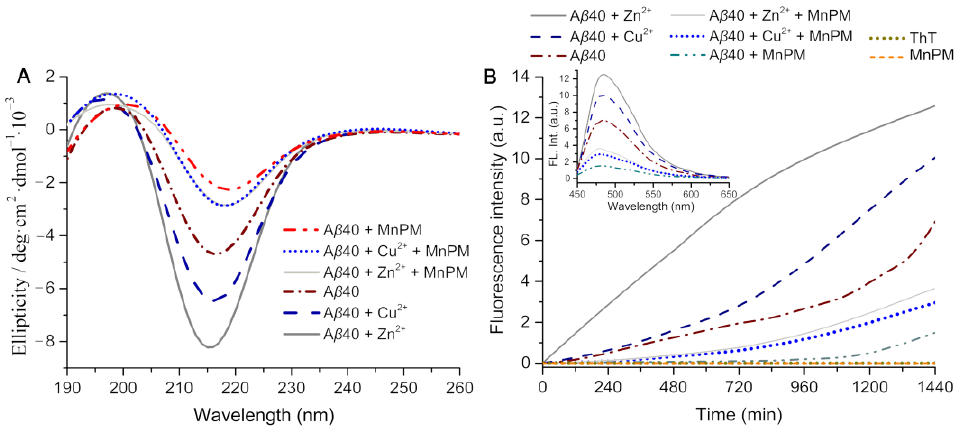
Figure 6. ( A ) CD spectra of A β 40 (20 µ M) and A β 40 in the presence of Cu 2+ or Zn 2+ (40 µ M) with or without MnPM (20 µ M) after incubation at 37 ◦ C for 24 h (All the samples with final DMSO content: volume ratio 0.5%); ( B ) ThT fluorescence intensity ( λ ex = 415 nm) of A β 40 (20 µ M) solutions in the absence and presence of Zn 2+ or Cu 2+ after incubation with or without MnPM at 37 ◦ C and pH 7.4 for 0–1440 min ([A β 40]: [metal ion]: [MnPM] = 1:2:1) (inset: ThT fluorescence spectra ( λ ex = 415 nm) of those A β 40 fibrils (20 µ M) with or without MnPM (20 µ M) at 37 ◦ C and pH 7.4 for 24